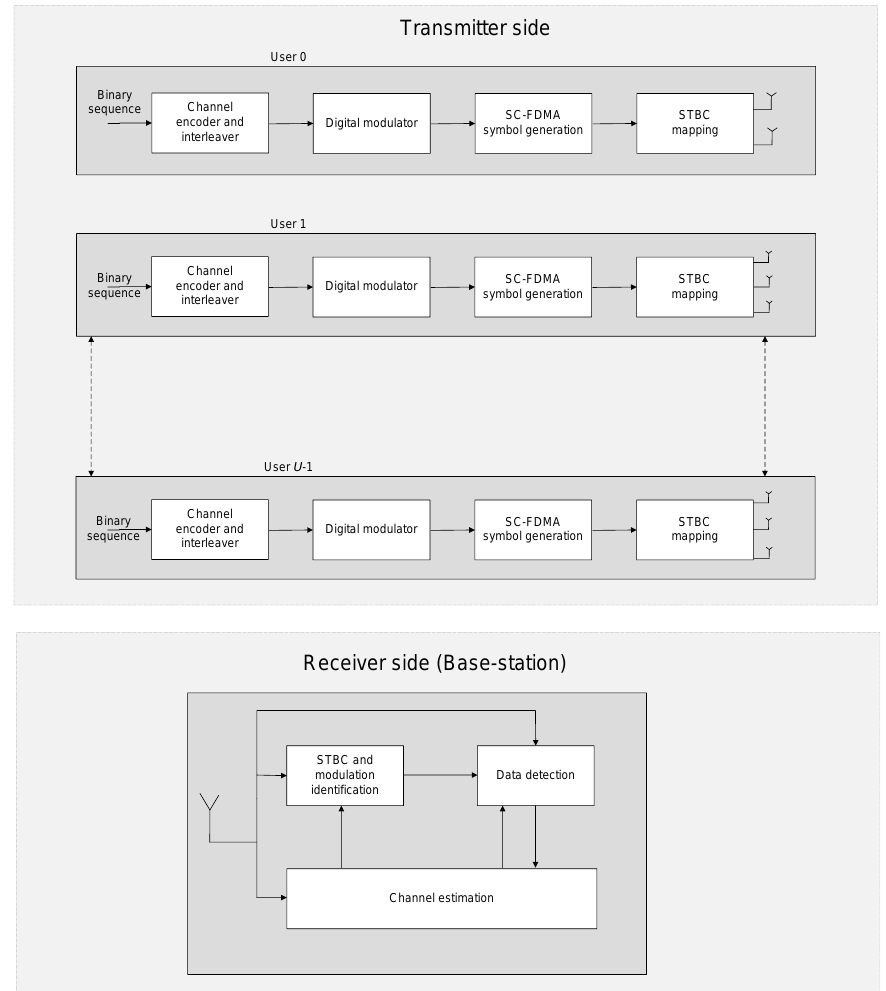
Figure 1. The block-diagram of the SC-FDMA system under